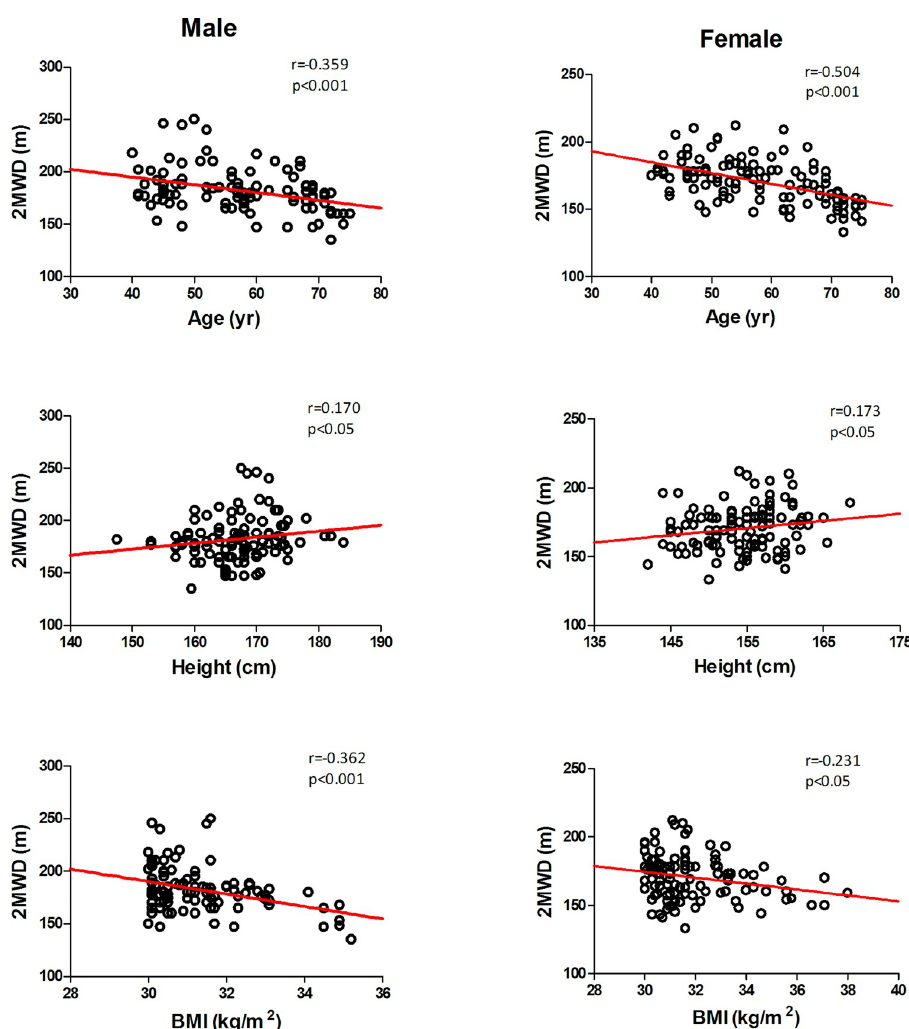
Fig 2. The relationship between 2MWD and age, height and BMI for females and